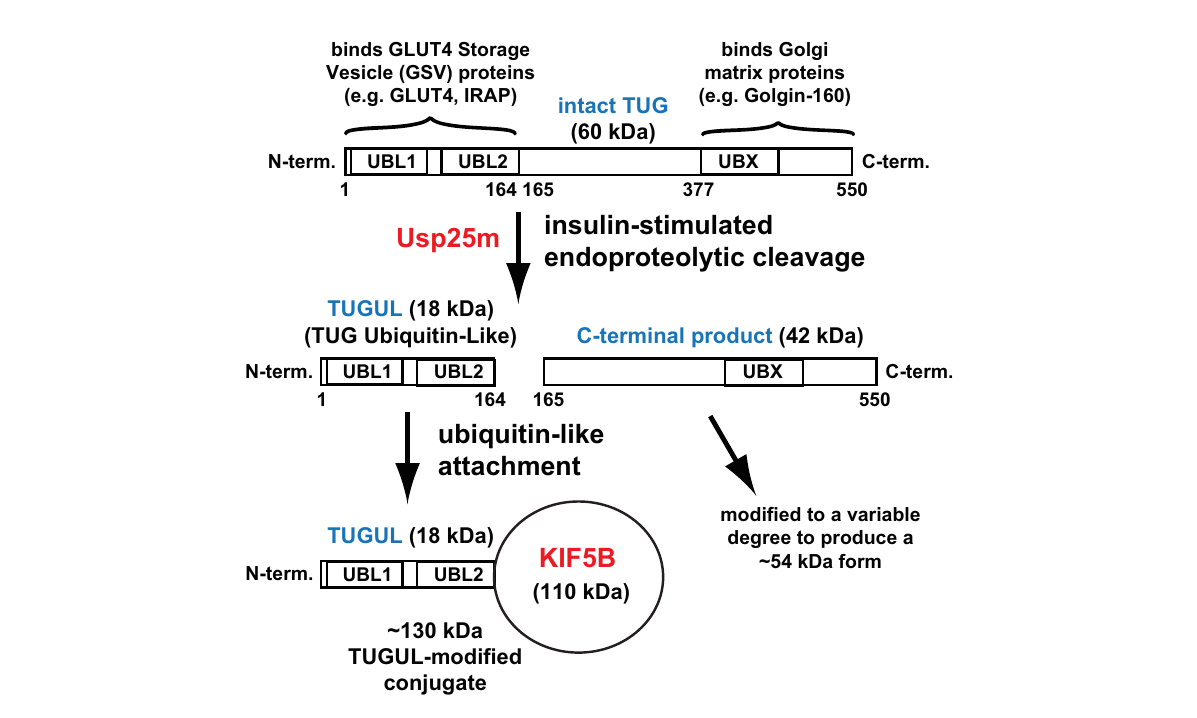
FIGURE 1 Ubiquitin-like proteolytic processing of TUG. Intact TUG protein is 60 kDa and has the domain structure that is shown. UBL1 and UBL2 are ubiquitin-like domains and UBX is a ubiquitin-regulatory X domain. The residues in the protein are numbered, as indicated, according to the mouse sequence. The N-terminal region binds GLUT4 Storage Vesicle (GSV) proteins, and the C-terminal region binds Golgi matrix proteins, as indicated. In fat and muscle cells, insulin stimulates endoproteolytic cleavage of intact TUG at the bond linking residues 164 and 165. Cleavage is mediated by the Usp25m protease and produces TUGUL (TUG Ubiquitin-Like), an 18 kDa ubiquitin-like protein modi fi er. The C-terminal product is 42 kDa and it is modi fi ed to a 54 kDa form to a variable degree. This modi fi cation is not understood. In 3T3-L1 adipocytes, TUGUL is covalently attached to a single target protein, the 110 kDa KIF5B kinesin motor, to produce a 130 kDa conjugate. In muscle, the TUGUL-modi fi ed ( “ tugulated ” ) protein has not been identi fi ed, and it is hypothesized that it is KIF5B or another kinesin motor. TUG cleavage liberates the GLUT4 storage vesicles from the Golgi matrix, and tugulation of the kinesin causes the movement of these vesicles toward the cell surface on these microtubule motors. The fi gure is modi fi ed from Habtemichael EN, et al.,